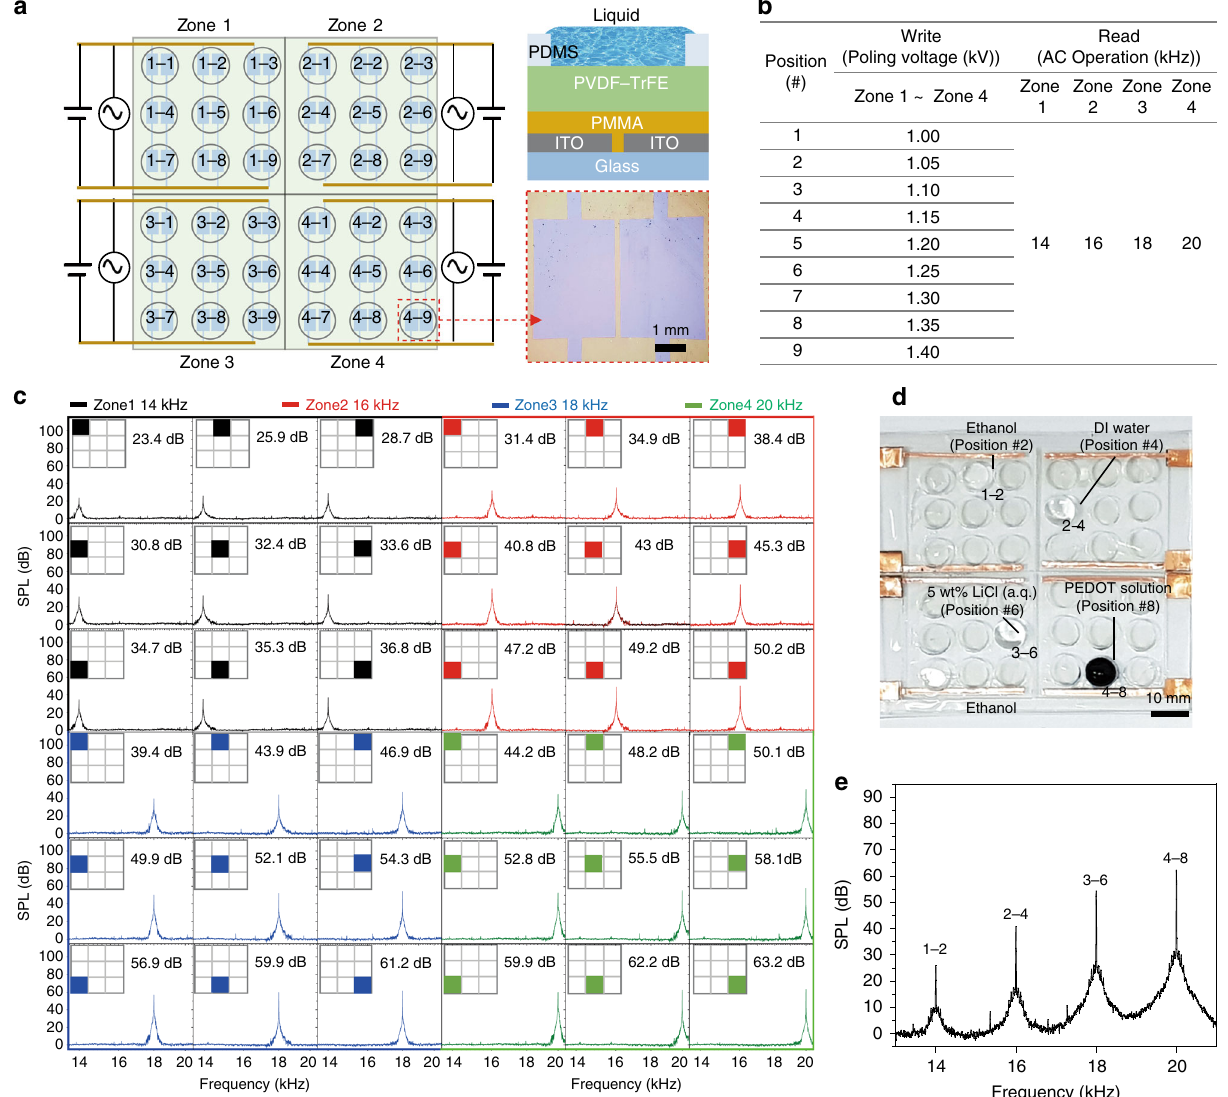
Fig. 5 Position detection of a liquid droplet by liquid-interactive ferroelectric sound. a Schematics of four sets of 3 × 3 liquid position detection pads for single and multi-droplet position detection. A schematic and a photograph of a single liquid-interactive ferroelectric sound (LIFS) alternating current (AC) device pixel with PDMS space. b Table showing the position marking process. Each 3 × 3 array pad was programmed with nine different direct current (DC) voltages ranging from 1.0 kV to 1.40 kV to develop nine different marking zones with different remnant polarisation values. Zones 1, 2, 3, and 4 were programmed with Ethanol, DI water, 5 wt% LiCl (a.q.) and PEDOT:PSS solution, respectively. The four different AC frequencies of 14, 16, 18, and 20 kHz were applied to zones 1, 2, 3, and 4, respectively, during the reading process. c Sound pressure level (SPL) spectra of the nine positions of each zone. Owing to the different reading frequency values of 14, 16, 18, and 20 kHz, nine positions of each 3 × 3 array pad were clearly resolved in the SPL. Nine different SPL values for each liquid were obtained, depending on the position, allowing for sound-based position detection of a liquid. d A photograph of the position detection pad with Ethanol (1 – 2), DI water (2 – 4), 5 wt% LiCl (a.q.) (3 – 6), and PEDOT:PSS solution droplets (4 – 8). e SPL spectra arising from the four droplets on the position detection pad. All SPL values were obtained at a voltage of 100